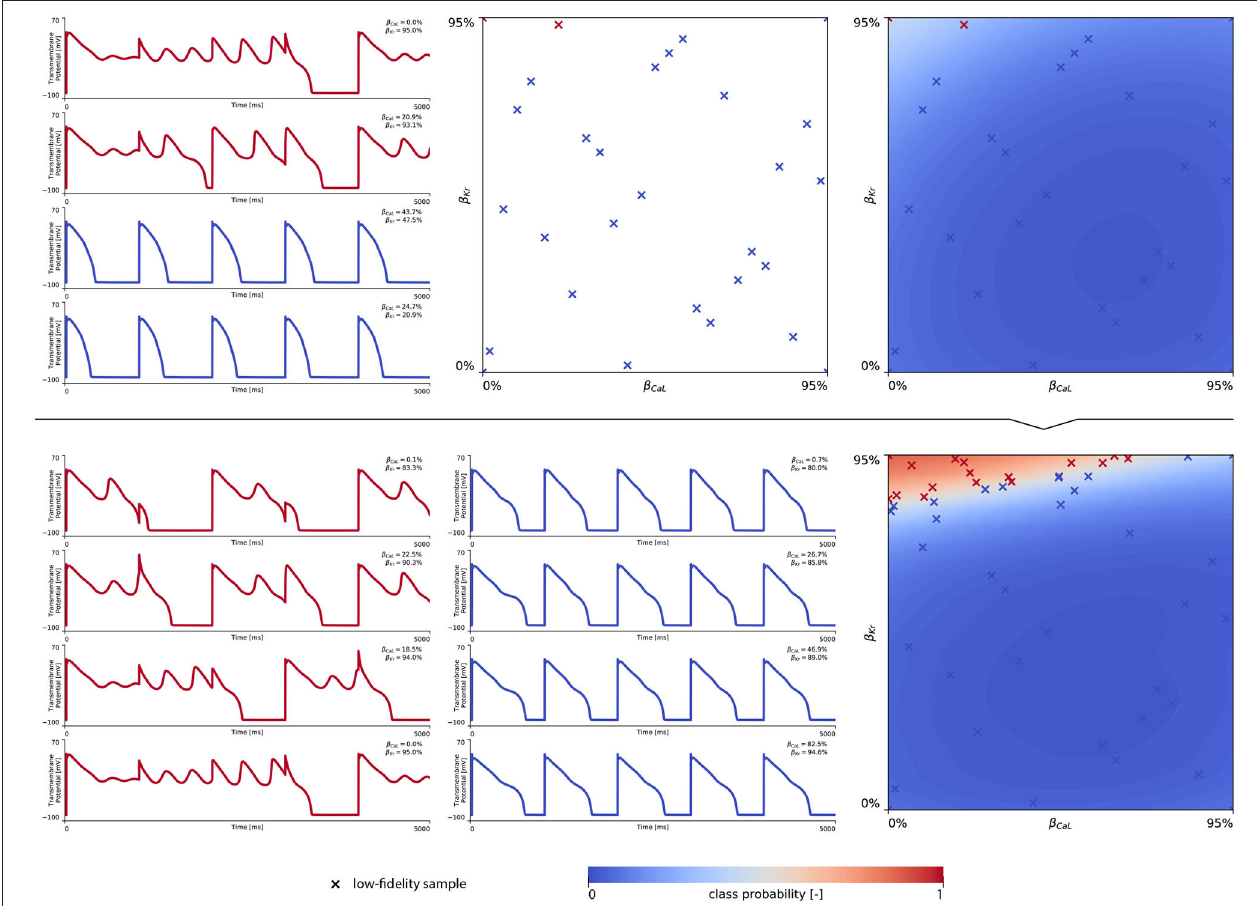
FIGURE A1 | Male single-fidelity drug-induced risk classifier. (Upper) Initial exploration of the drug-induced de- and repolarization abnormality risk parameter space. The first 25 internal latin hypercube samples of the B = { β Kr , β CaL } parameter space were evaluated for male midwall cell abnormalities, as showcased in the upper middle plot. Transmembrane potential evolution profiles of two normal and two early depolarizing samples are shown on the upper left plot. Using this exploratory B dataset, an initial single-fidelity drug-induced risk classifier was trained for the male midwall cell, see upper right subplot. (Lower) Exploration and exploitation of the drug-induced risk classification boundary using active learning. The Gaussian process classifier was trained further using 25 additional active learning { β Kr , β CaL } samples. On the lower left, four active learning sample evaluations resulting in abnormalities are shown. The lower middle plot showcases four active learning sample evaluations that showed normal action potentials. The final male cellular drug-induced risk classification boundary is shown in the lower right